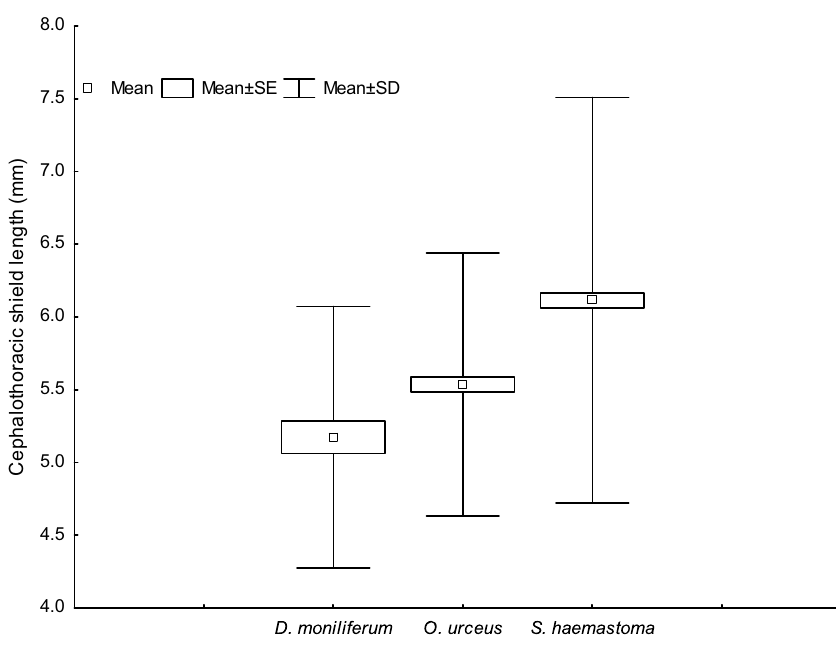
Fig. 2 – Clibanarius vittatus . Mean, standard deviation and standard error of the hermit crabs’ cephalothoracic shield that occupied three more frequent shell species.